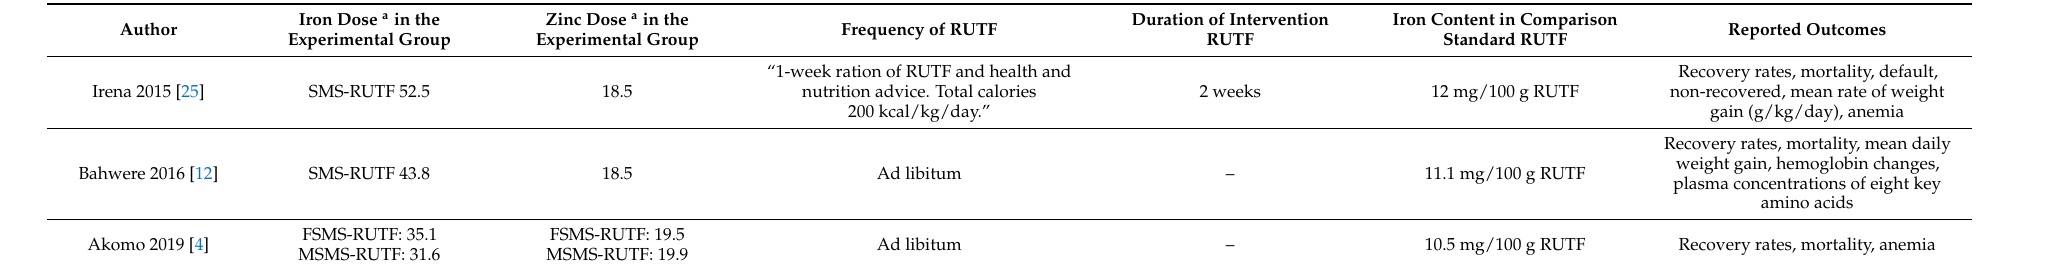
Table 2. Treatment characteristics in the included